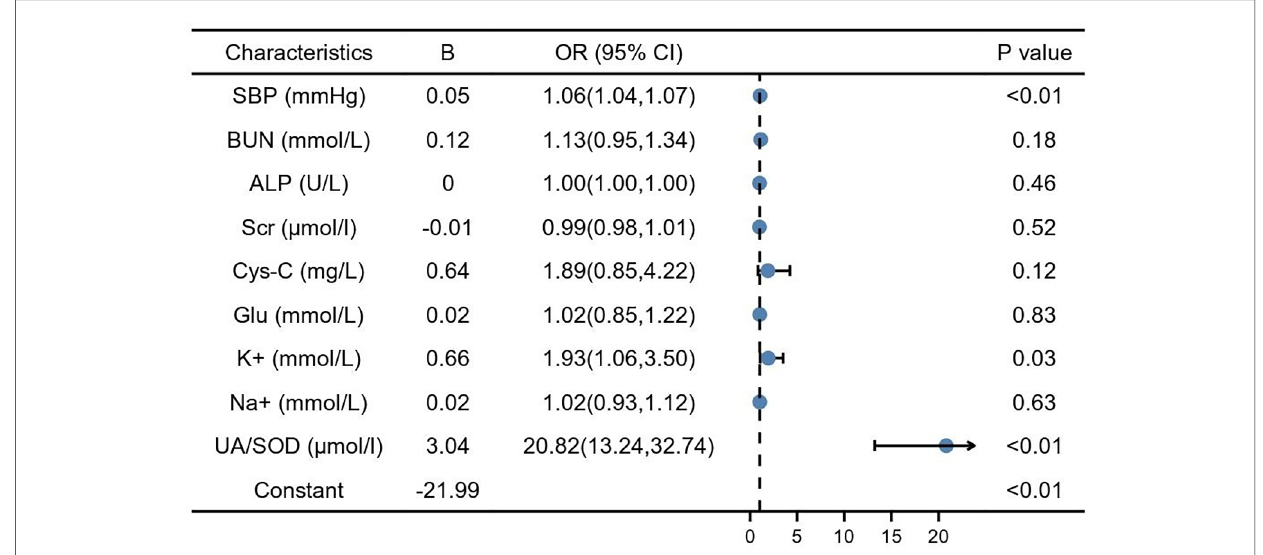
FIGURE 2 Multiple factor logistic analysis. SBP, systolic blood pressure; BUN, blood urea nitrogen; Scr, serum creatinine; Cys-C, cystain C; Glu, glucose; TBIL, total bilirubin; TBA, total bile acid; DBIL, direct bilirubin; ALP, alkaline phosphatase; Na+, natrium; K+, potassium; UA, blood uric acid; SOD, superoxide dismutase.